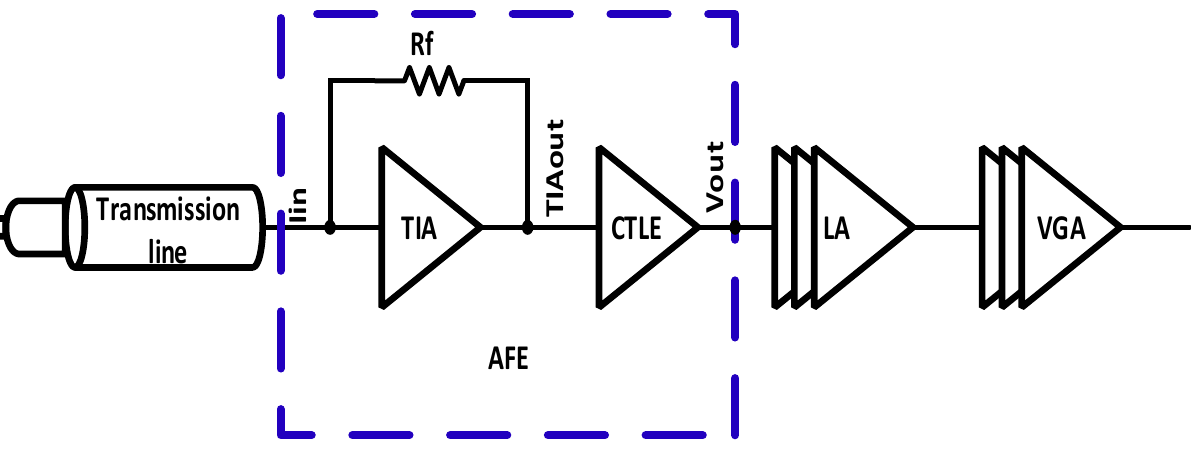
Figure 1. Block Diagram of a Receiver with an AFE.